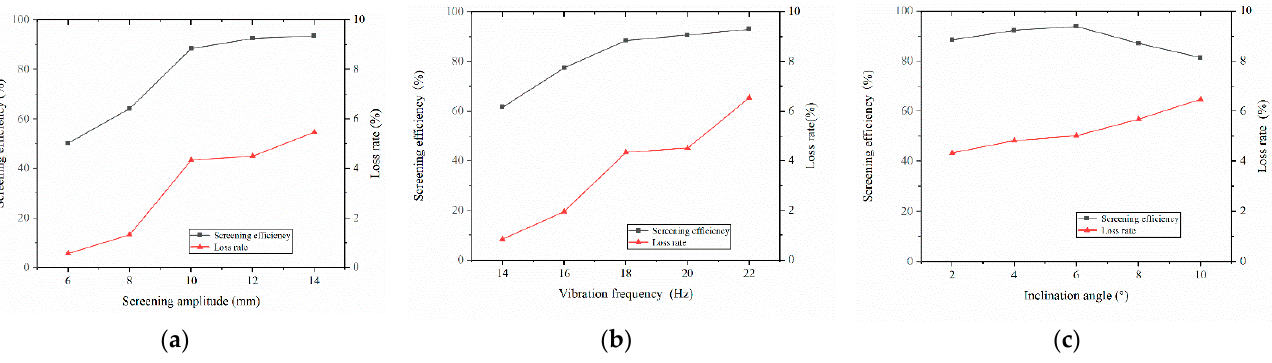
Figure 10. Curve of the screening efficiency rate and loss rate. ( a ) Curve of the screening efficiency rate and loss rate with amplitude; ( b ) Curve of the screening efficiency rate and loss rate with frequency; ( c ) Curve of the screening efficiency rate and loss rate with angle.